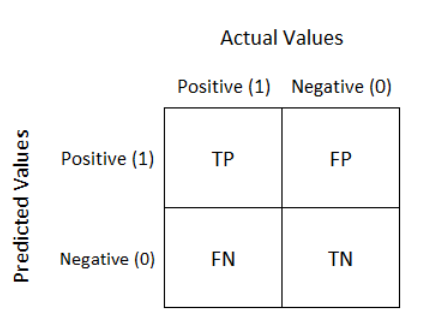
Figure 4. Confusion